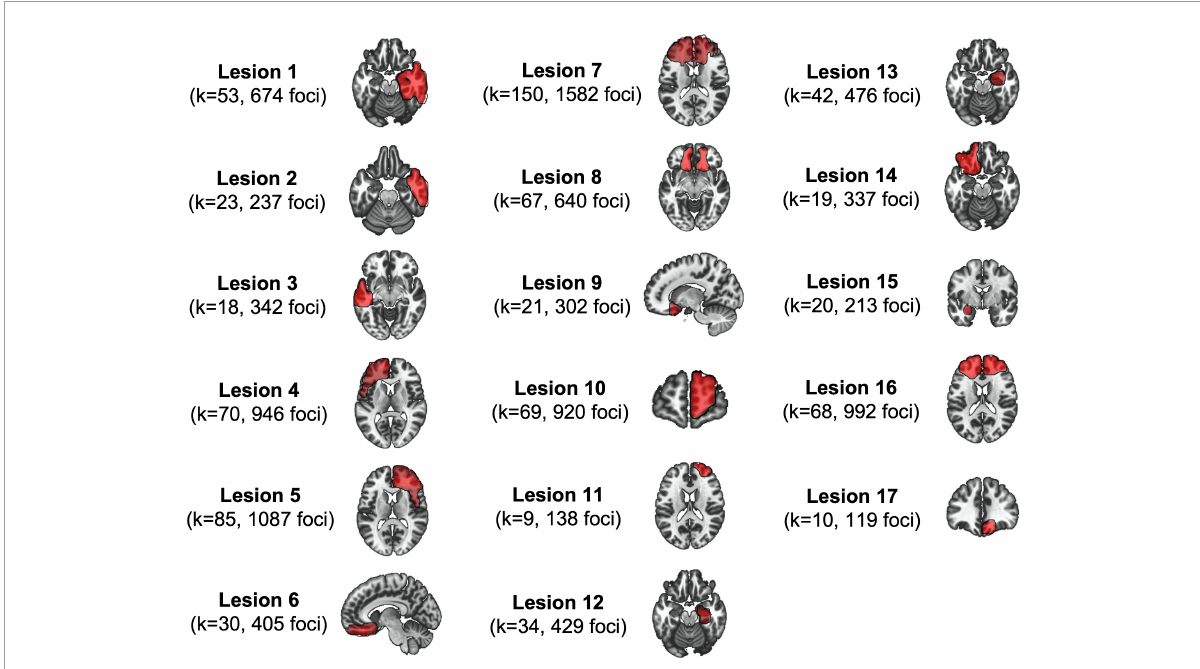
FIGURE1 The 17 lesions associated with antisocial behaviors. This figure shows lesion masks (seeds) as well as their respective meta-analytic informations derived from the Antisocial Brain